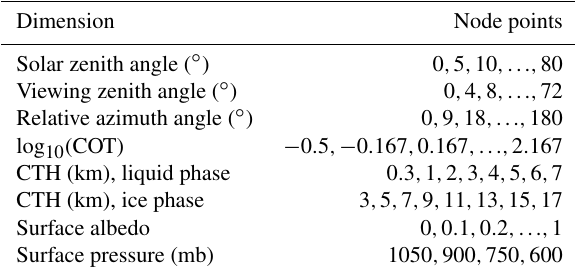
Table 1. Radiative transfer LUT node points for each satellite chan- nel in the CHROMA algorithm.